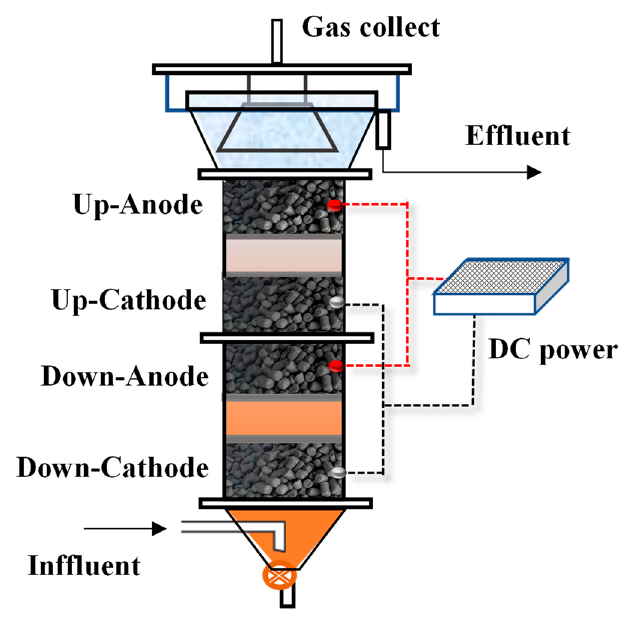
Figure 1. Schematic representation of the reactor [14].